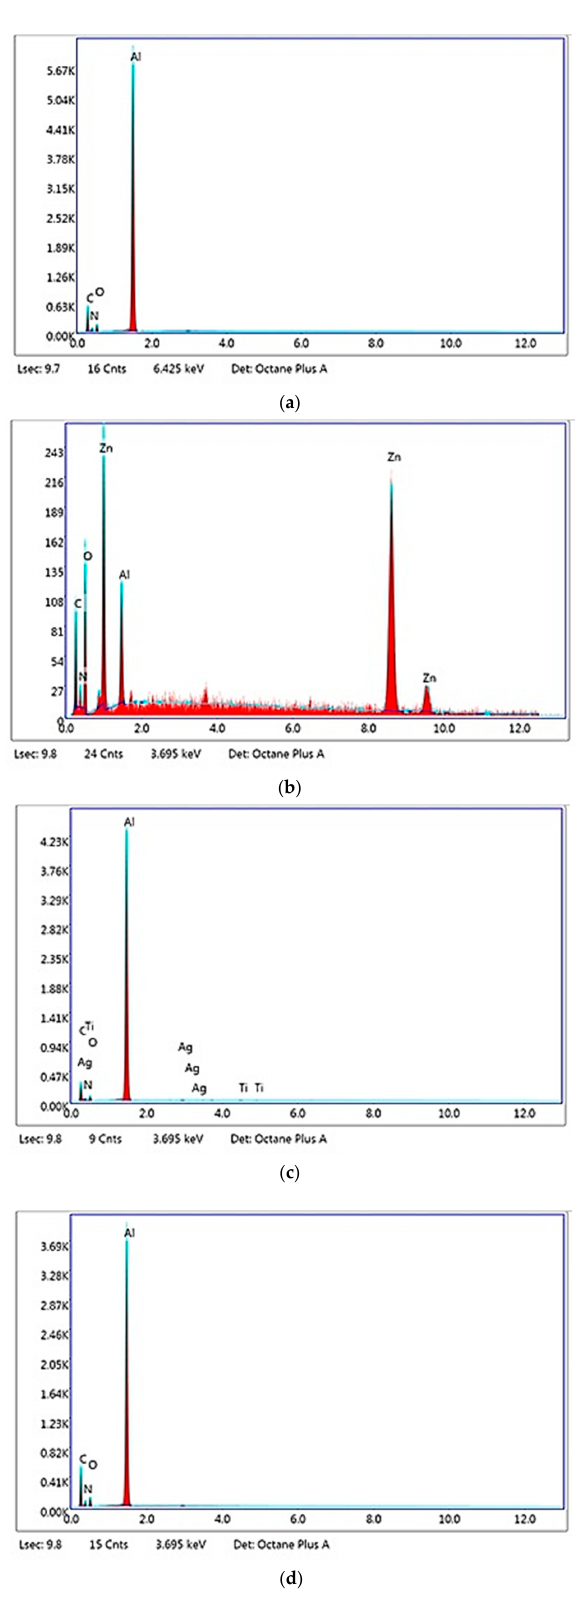
Figure 3. EDS patterns for: Col—collagen glue nanofibers ( a ) , Col/ZnO NPs ( b ) , Col/TiO 2 -N-Ag NPs ( c ) , and Col/CS ( d ). Table 3. Mass and atomic compositions for the electrospun collagen nanofibers.